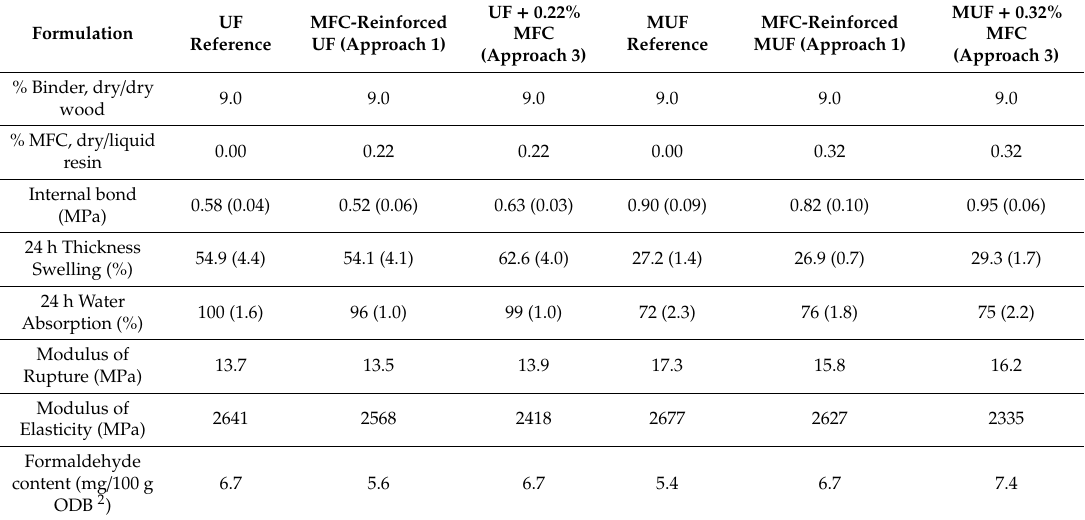
Table 2. Particleboard panels analysis, MFC 2% suspension, Approach 1 vs. Approach 3, Average property values, Standard deviation 1 (in